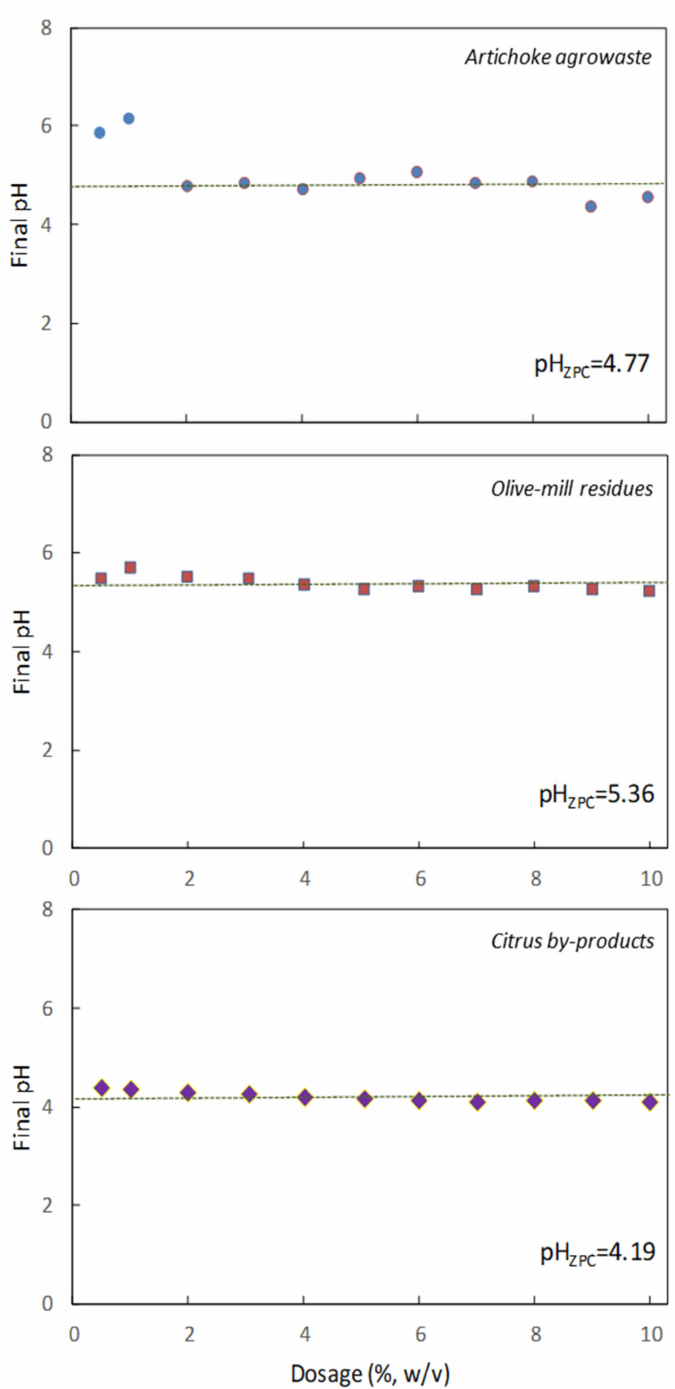
Figure 8. Plots for the pH of zero point of charge determinations. Because imazalil and thiabendazole are azole biocides (Table 2) with dissociation constants (pK a ) at 25 ◦ C of 6.53 and 4.73, respectively [58], the sorption experiments were conducted at pH 7.0 to achieve a net negative charge on the surface of the powder sorbents and a positive charge around the nitrogen atoms present in the molecules of both biocides, in a way that facilitated electrostatic binding mechanisms to enhance the bioremoval of both